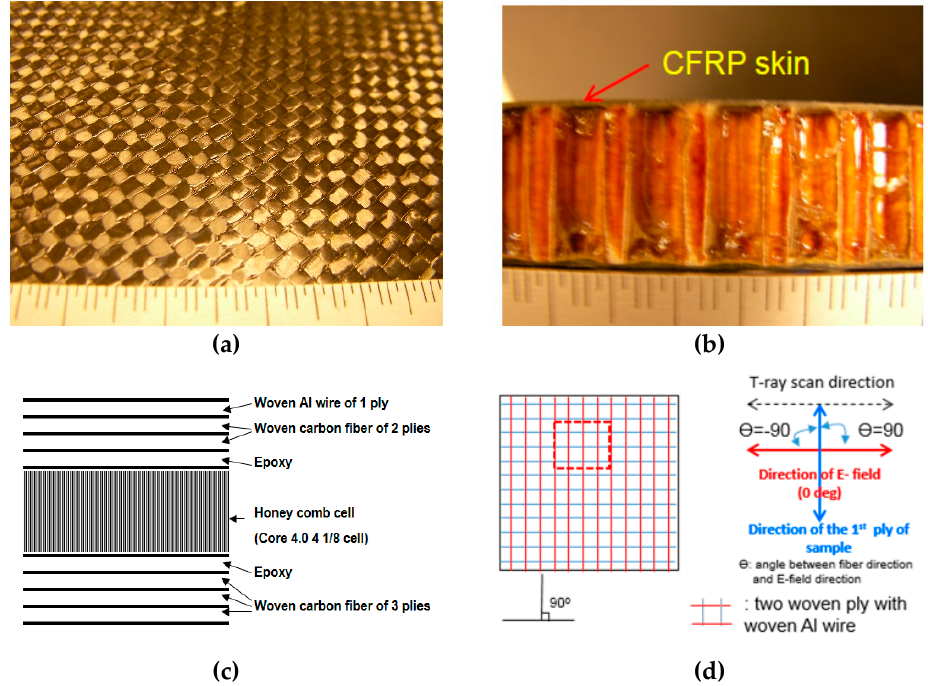
Figure 5. Overall diagrams for the terahertz reflection mode and CFRP skin sandwich composite panels with Al wires embedded on the surface. ( a ) Al wires on a sandwich panel; ( b ) Cross section of a sandwich panel; ( c ) Configuration of cross section; ( d ) T-ray testing configuration.